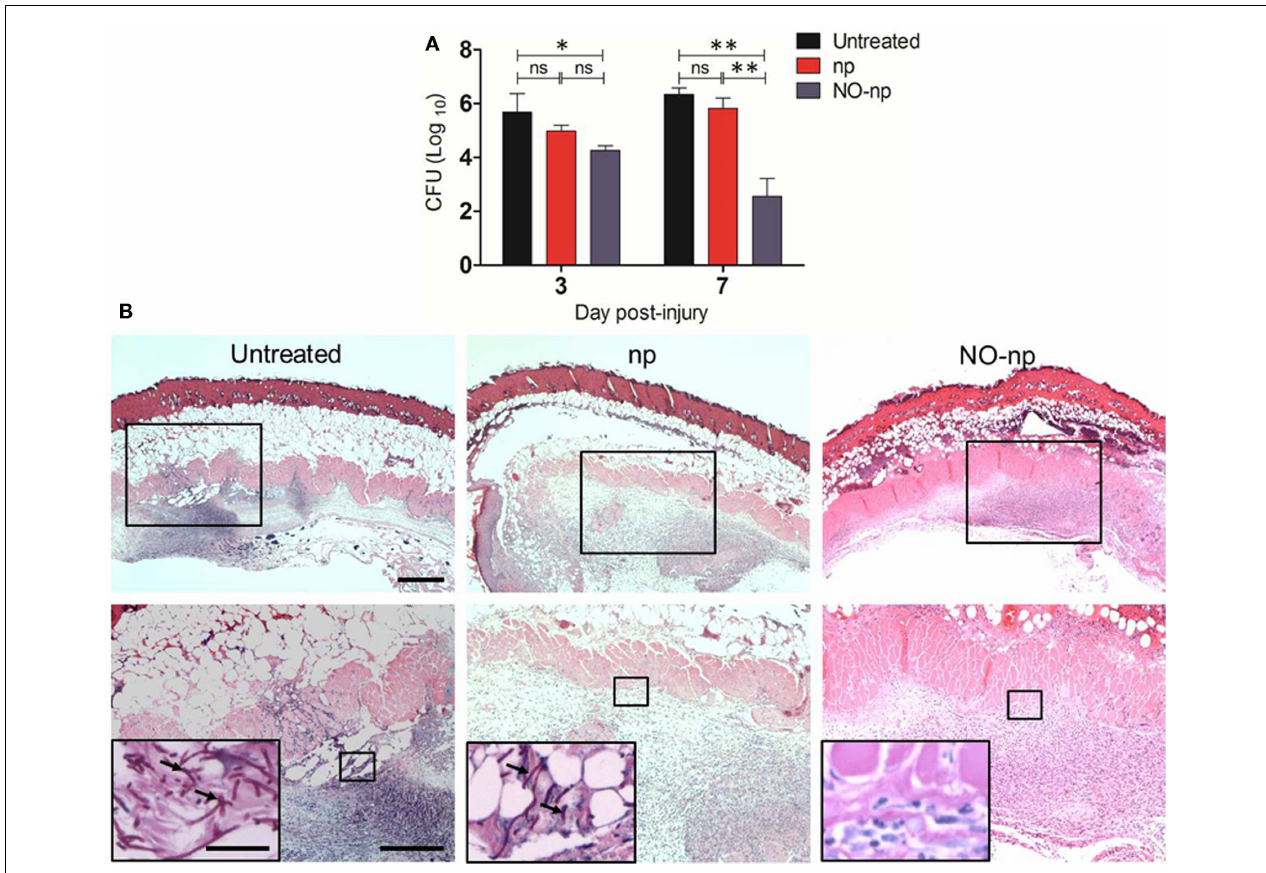
Bonferroni correction. (B) Histological analysis of Balb/c mice untreated C. albicans -infected, np-treated C. albicans -infected, and C. albicans -infected treated with NO, day 7. Mice were infected with 10 7 C. albicans . Representative H&E-stained sections of the skin lesions are shown with the Insets showing Periodic acid schiff staining of C. albicans . Black arrows indicate fungal pseudohyphae and hyphae. Scale bars: 20 µ